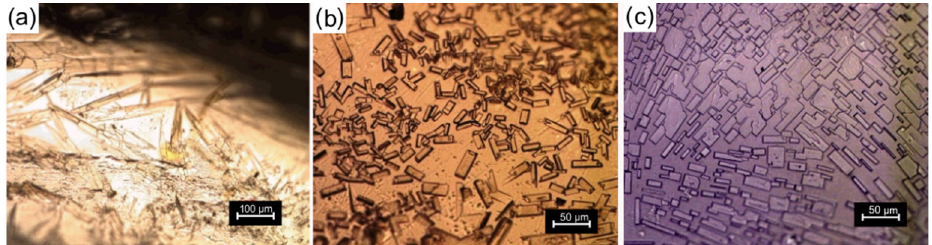
Figure 7. Optical microscopy images in transmission mode of HPG-OA1 hydrogels impregnated in ibuprofen (IBU) solutions of ( a ) 0.05 g mL − 1 (200 × ), ( b ) 0.5 g mL − 1 (400 × ) and ( c ) 0.75 g mL − 1 (400 × ).